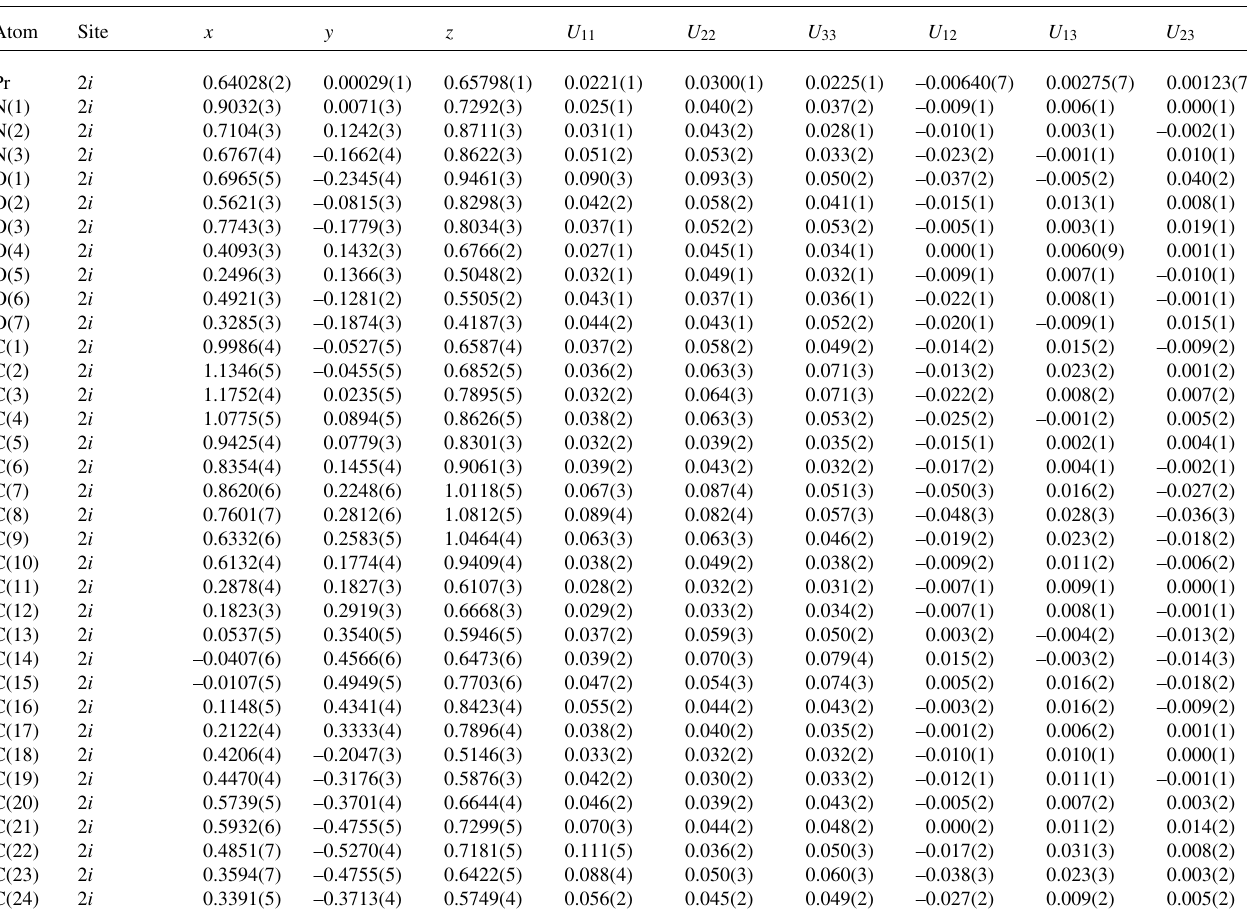
Table 3. Atomic coordinates and displacement parameters (in Å 2 ) .